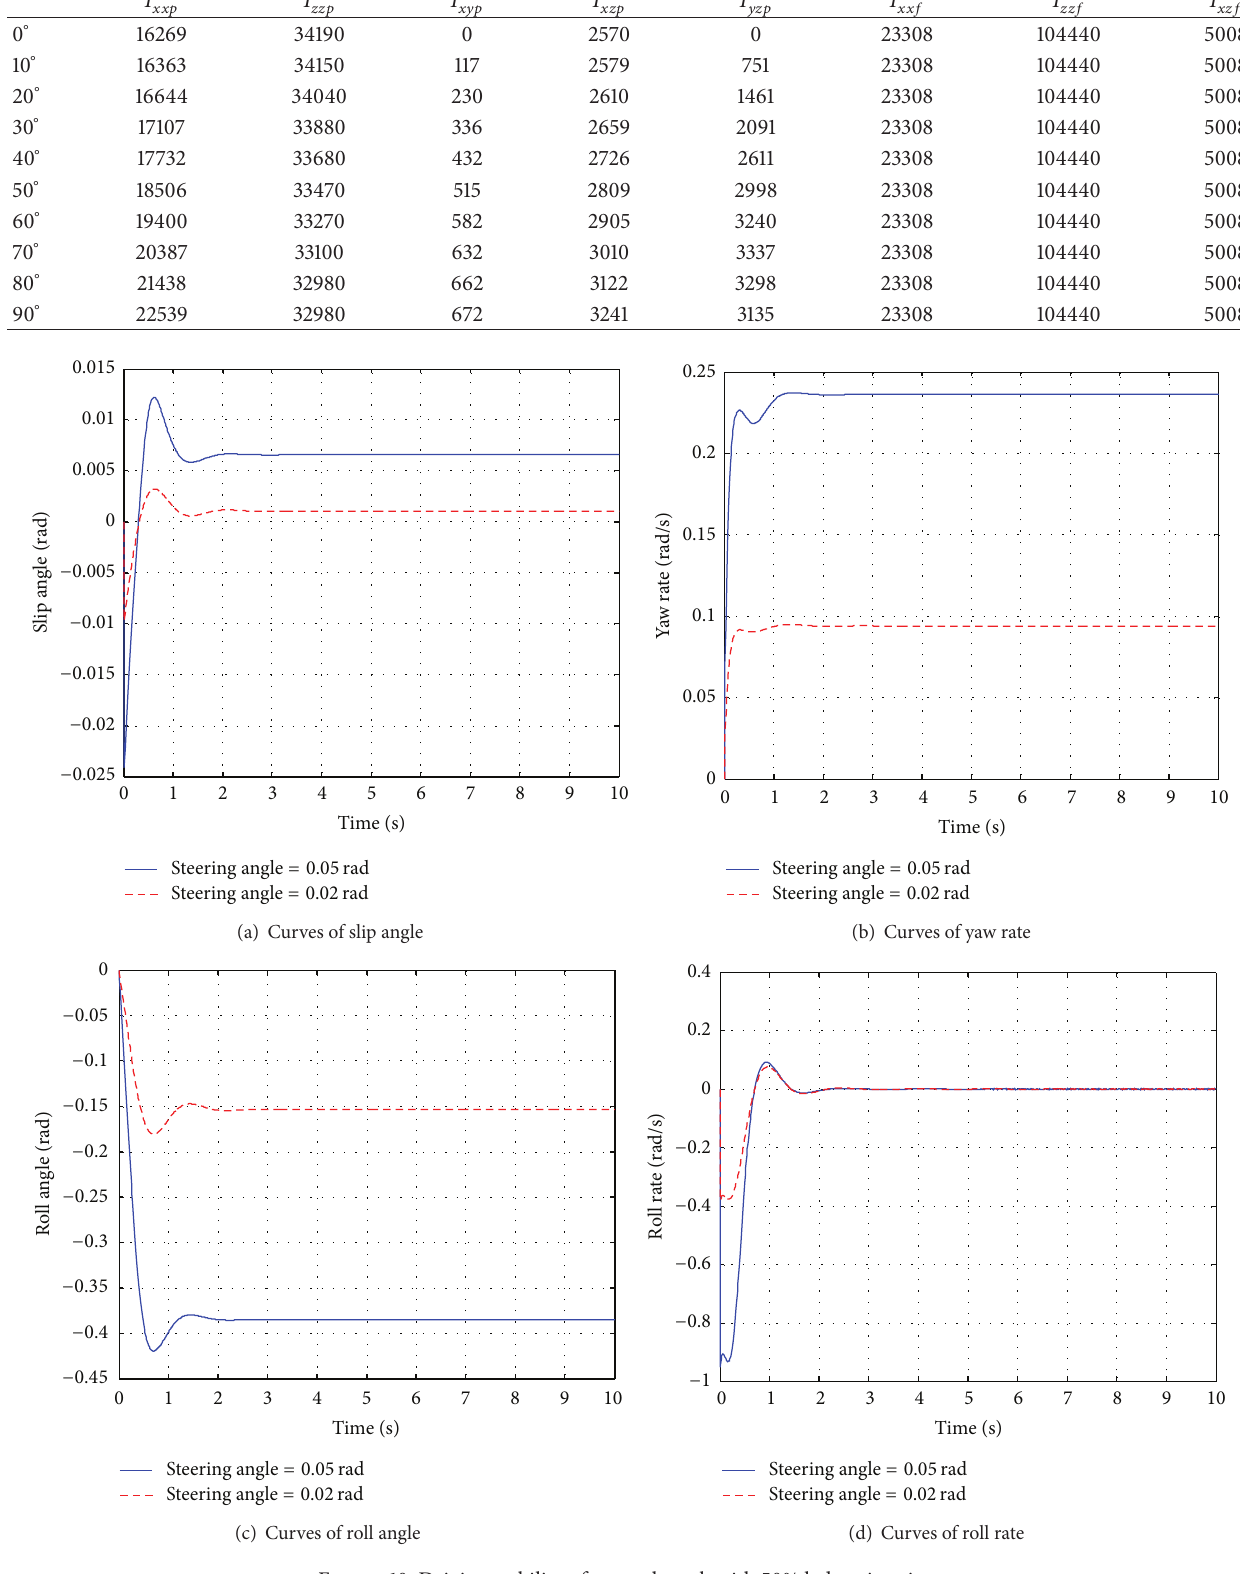
Figure 10: Driving stability of normal truck with 50% laden